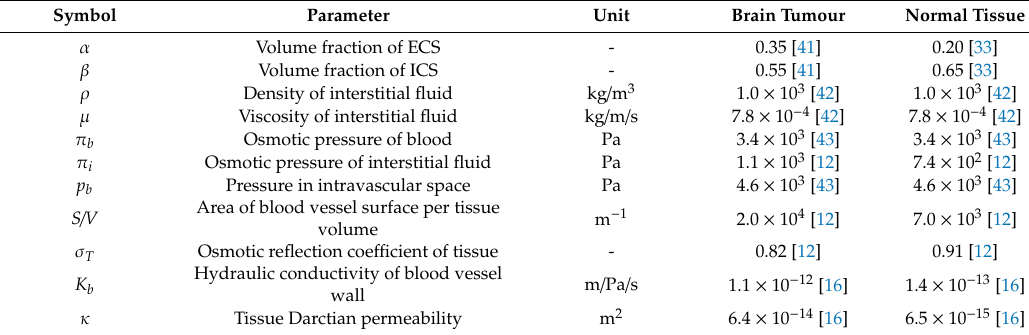
Table 2. Parameters for the brain tumour and normal